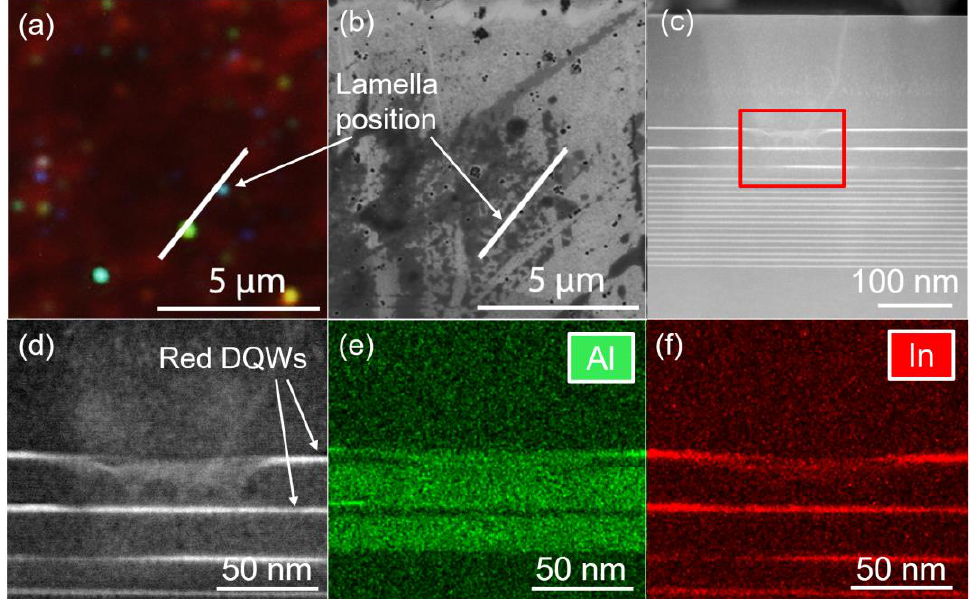
Figure 5. ( a ) EL mapping and ( b ) scanning electron microscope (SEM) image used for the lamella positioning. ( c ) Scanning transmission electron microscope (STEM) image and ( d ) high-resolution STEM image of our active region structure. ( e ) Al and ( f ) In atom distribution mapping in the active region by STEM energy dispersive X-ray spectroscopy (EDS) measurements.